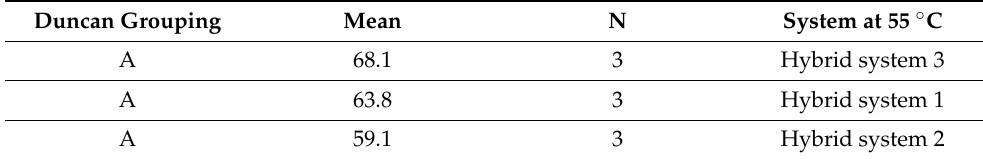
Figure 10. Comparison results of combined thermal efficiency. Table 6. Statistical analysis results of combined thermal efficiency.